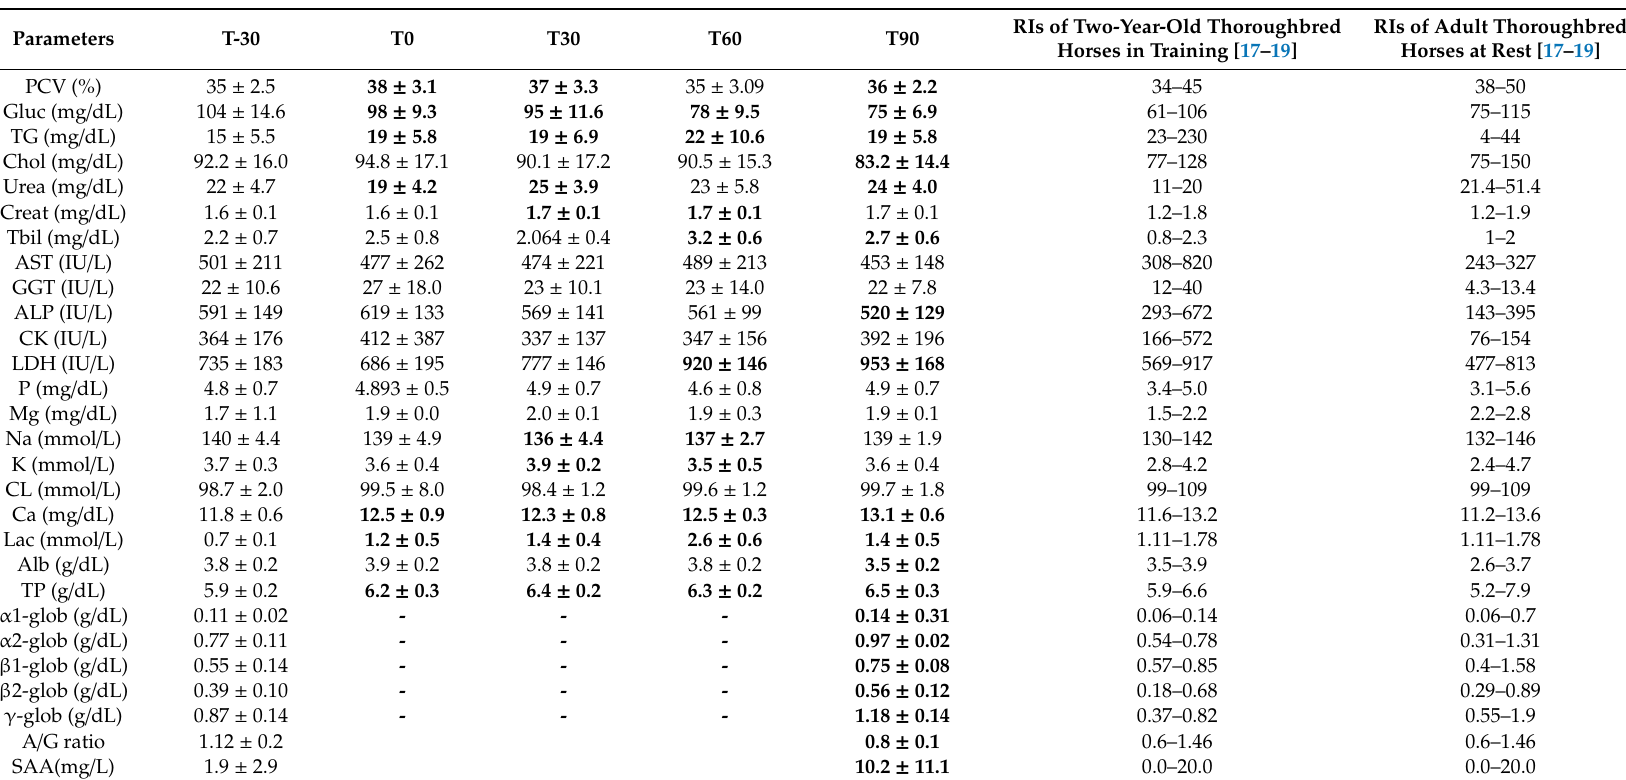
Table 3. Means ± standard deviations of biochemical and electrophoretic parameters. Parameters significantly modified compared with T-30 are in bold.